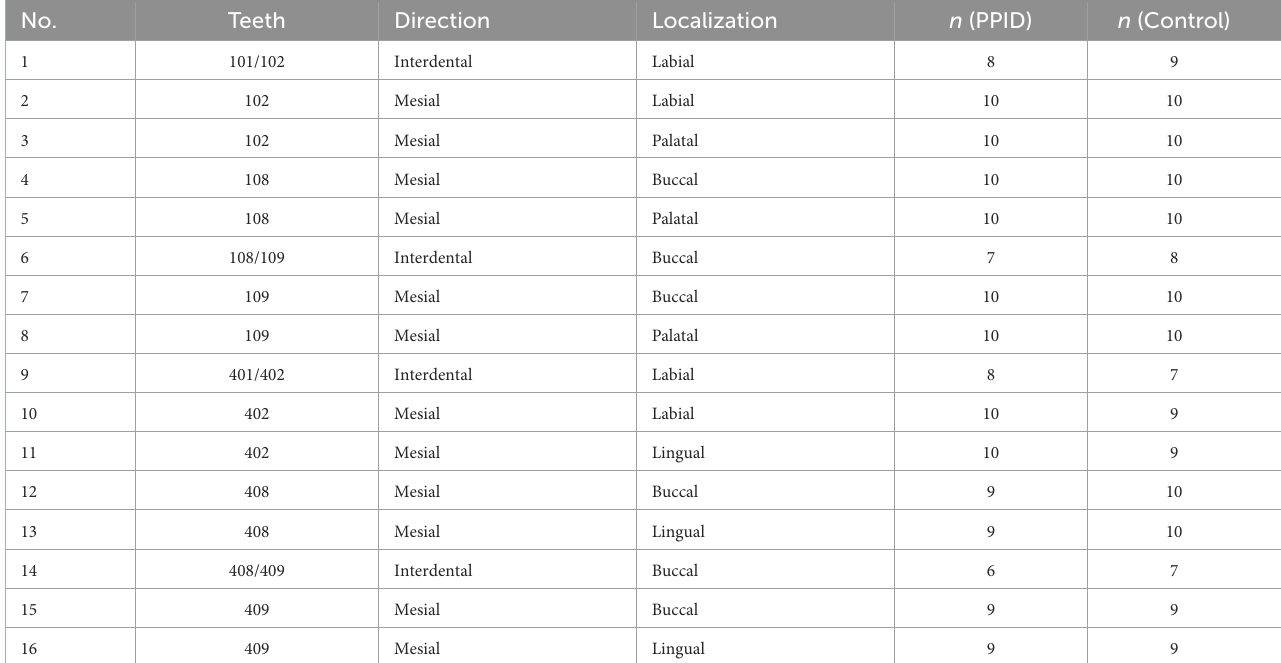
TABLE 2 Locations and numbers of histologic